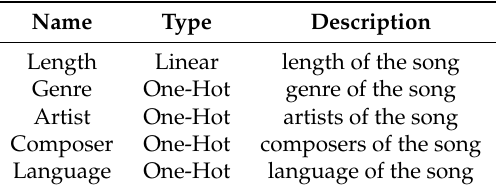
Table 1. The meta fields used in music feature